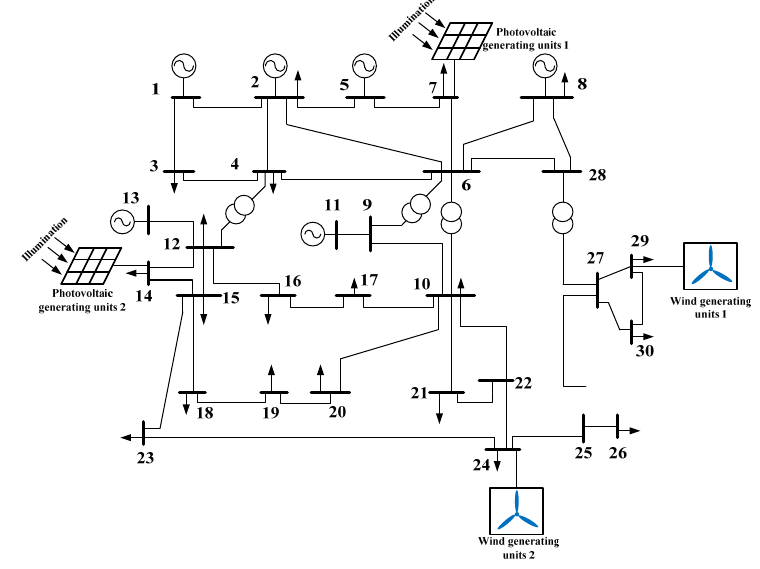
Figure 4. DGs connected to the IEEE 30 ‐ bus system